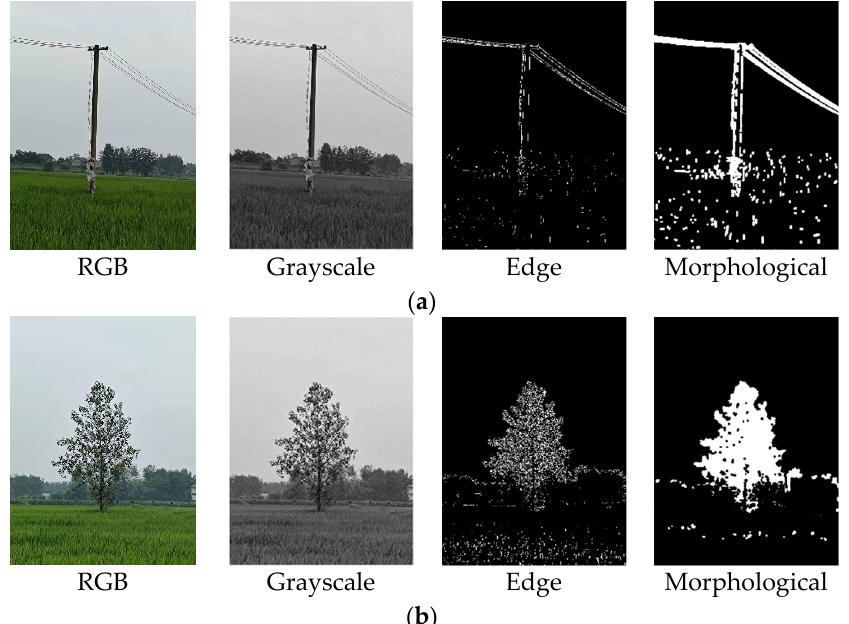
Figure 9. Contour extraction of field obstacles: ( a ) wire poles; ( b )